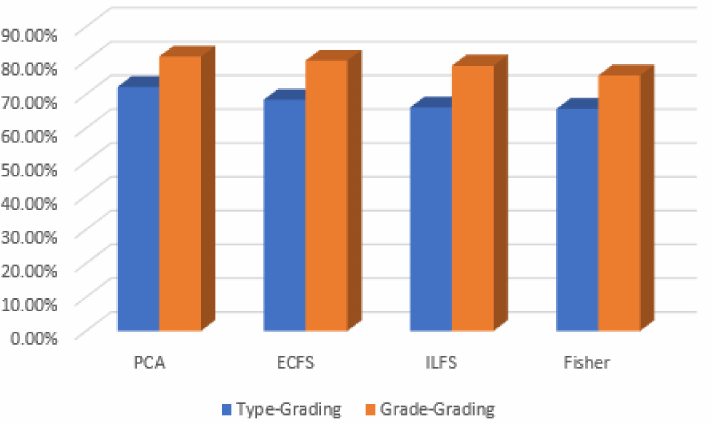
Figure 30. Accuracy for the 30 most significant features for severity grading and type grading employing automatic features.